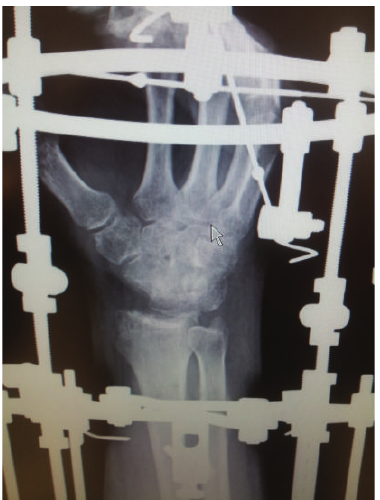
Figure 3: Maximal wrist distraction in